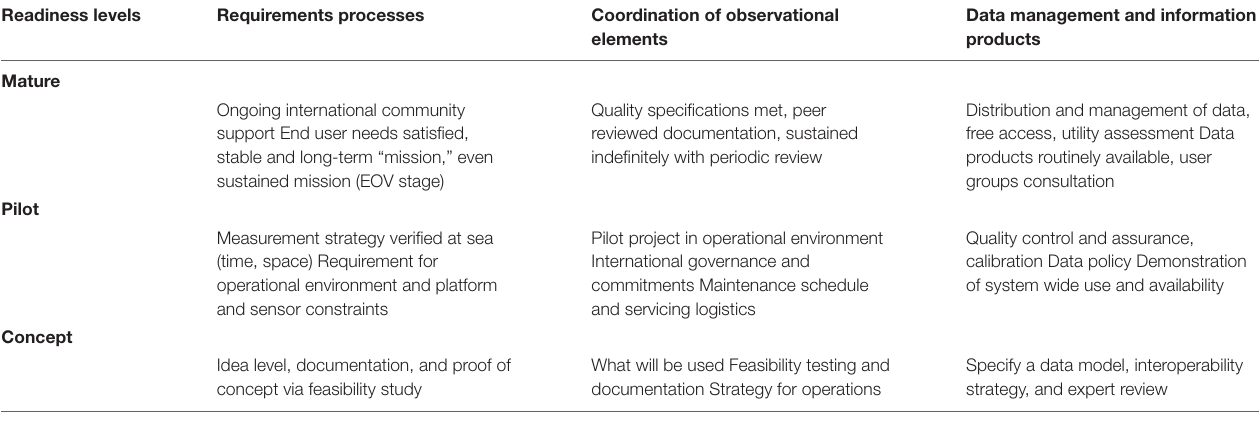
TABLE 1 | Readiness levels for ocean observing value chain assessments adopted for the VOICE initiative.